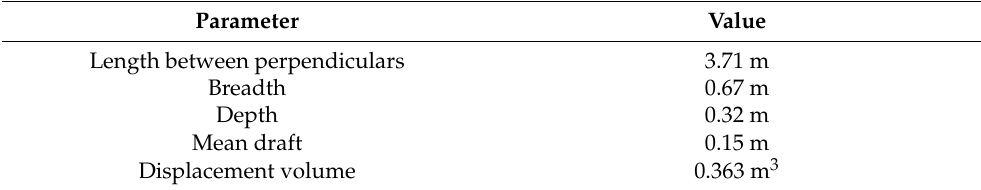
Table 8. Principal particulars of the FPSO